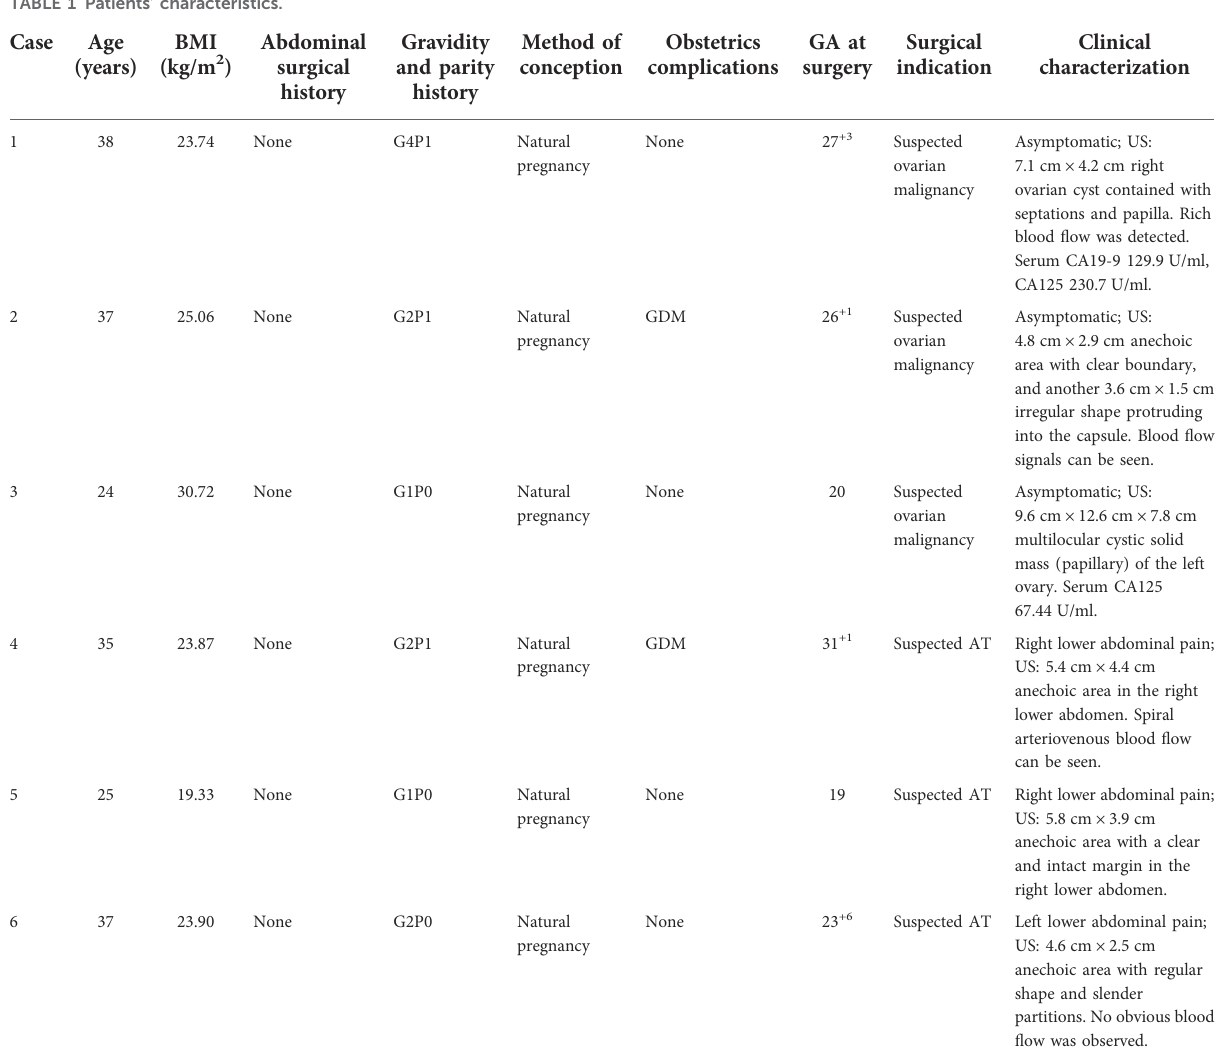
TABLE 1 Patients ’